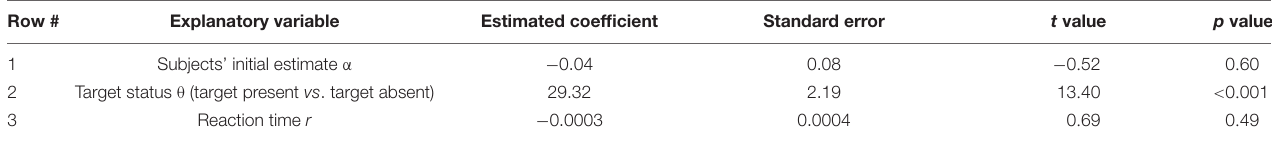
Target status θ (target present vs . target absent)